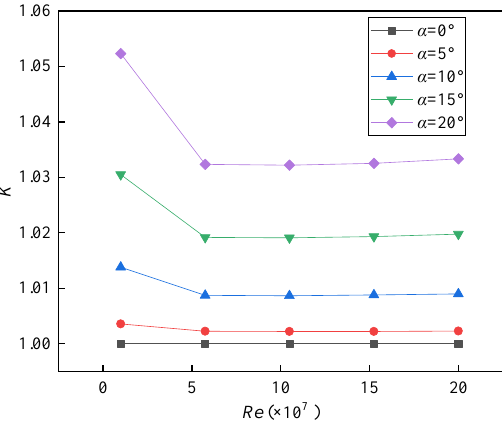
Figure 8. Correction coefficient K vs. Re ( e = 2).